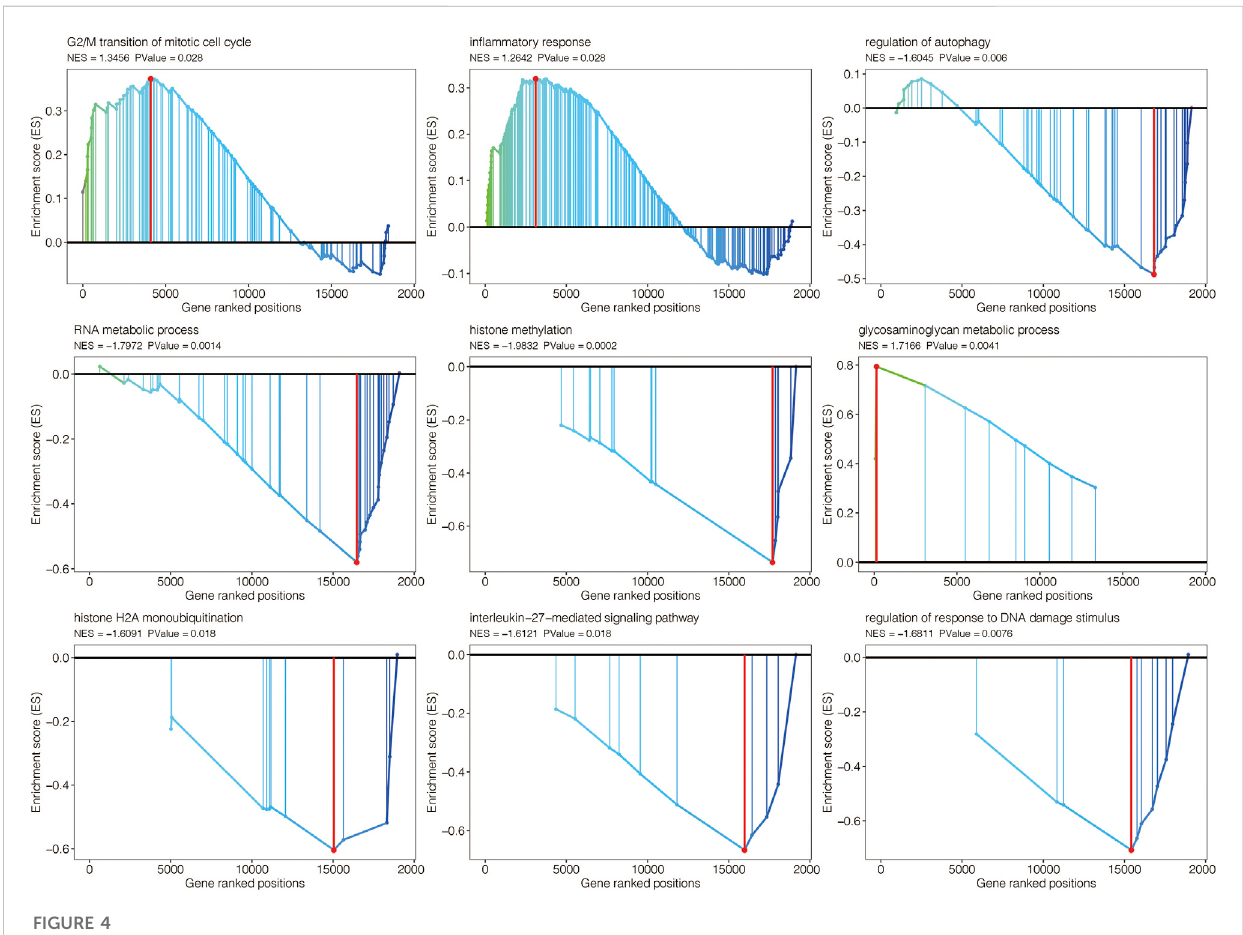
FIGURE 4 GSEA for GO pathways related to the AAA-related genes in